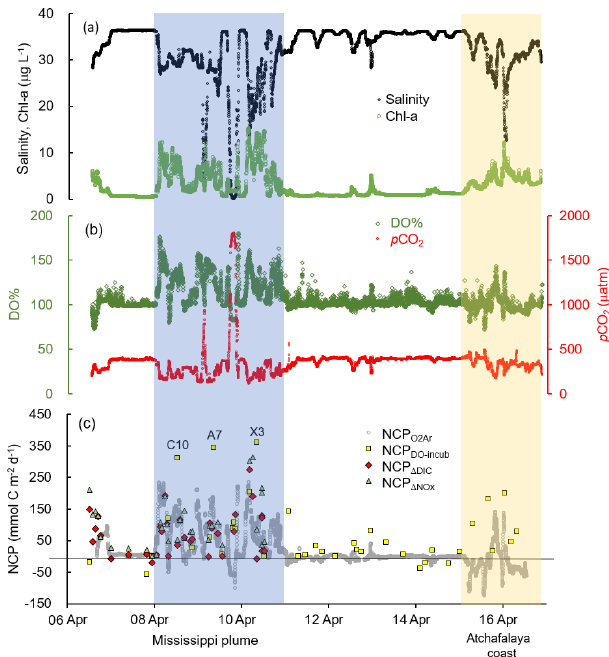
Figure 3. The underway measurements of (a) salinity and Chl a , (b) DO% and p CO 2 , and (c) NCP rates estimated from the O 2 / Ar mea- surement (NCP O , grey circles). Also shown in (c) are the NCP 2 Ar rates estimated from the light/dark DO incubation (NCP DO-incub , yellow squares), non-conservative changes in DIC (NCP (cid:49) DIC , red diamonds), or NO x (NCP (cid:49) NO x , green triangles). See Fig. 1 for the cruise track in the Mississippi plume (8–11 April) and Atchafalaya coast (15–17 April). See Fig. 5 for the positions of stations C10, A7, and X3 in the Mississippi